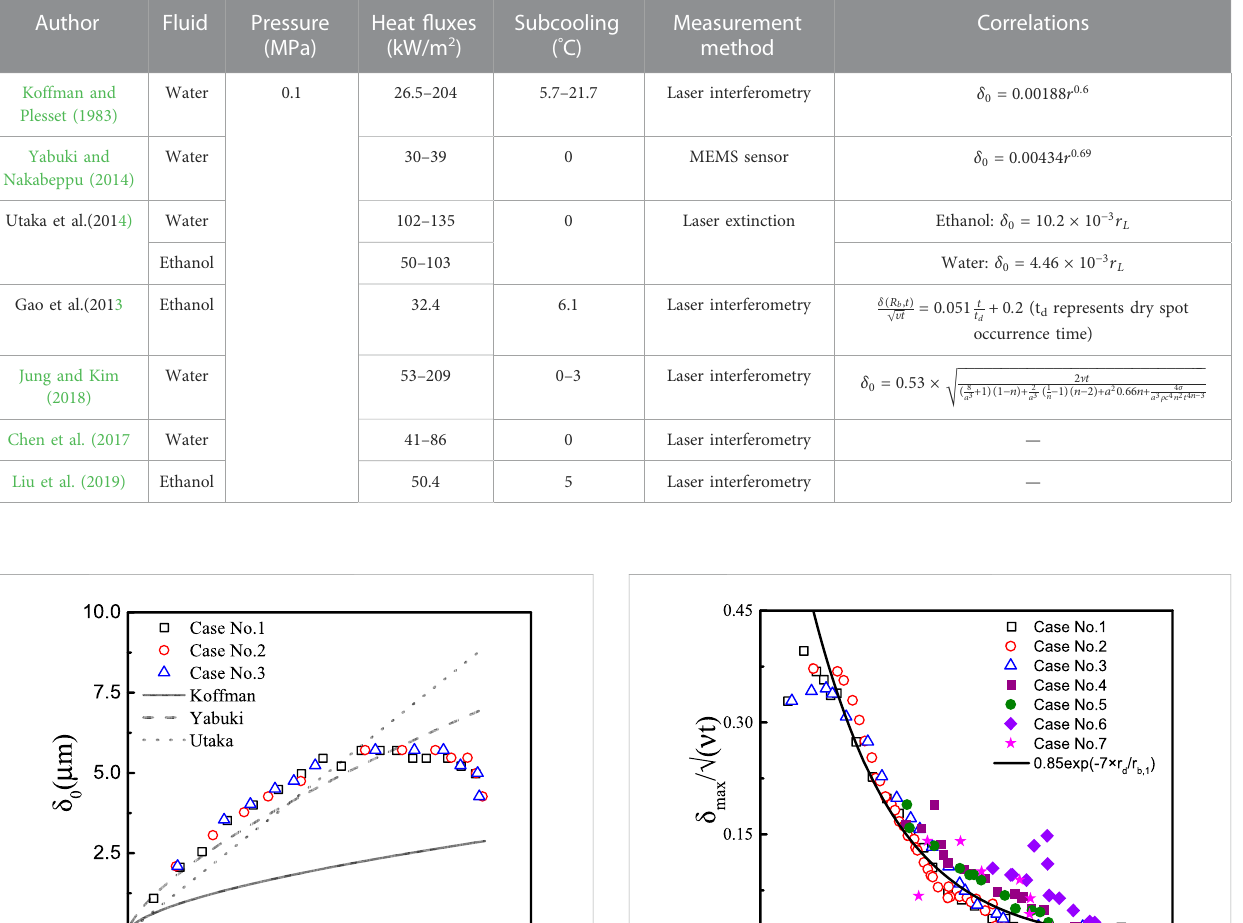
TABLE 3 Previous experimental studies for the initial microlayer thickness.